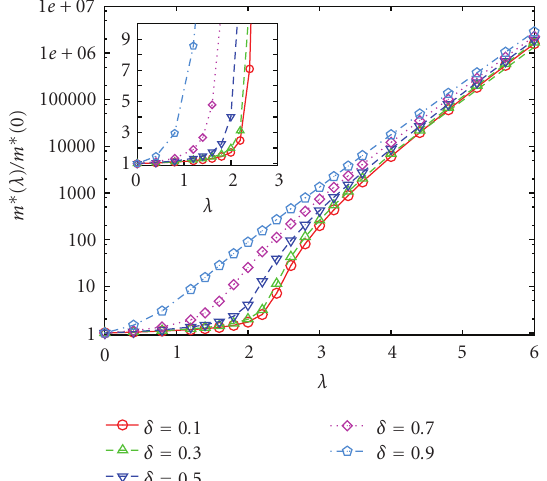
Figure 9: Renormalization of the e ff ective mass due to electron- phonon coupling for infinite U and ω 0 /W = 0 . 1 as a function of λ for di ff erent doping levels. The inset shows the same data in a smaller range. Here the doping δ is given by δ = n − 1 and λ is twice as in the rest of the paper (after Barone et al.